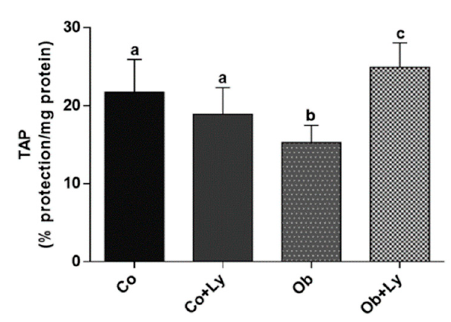
Figure 6. Total antioxidant performance test (TAP) (% protection/mg protein). Co: Control group; Co + Ly: Control group supplemented with lycopene; Ob: Obese group; Ob + Ly: Hypercaloric group supplemented with lycopene. Data parametric expressed in mean ± standard deviation. Comparison by two-way ANOVA with Holm-Sidak post-hoc. Different letters correspond to the significant statistical difference ( p < 0.05); n = 6 animals/group.